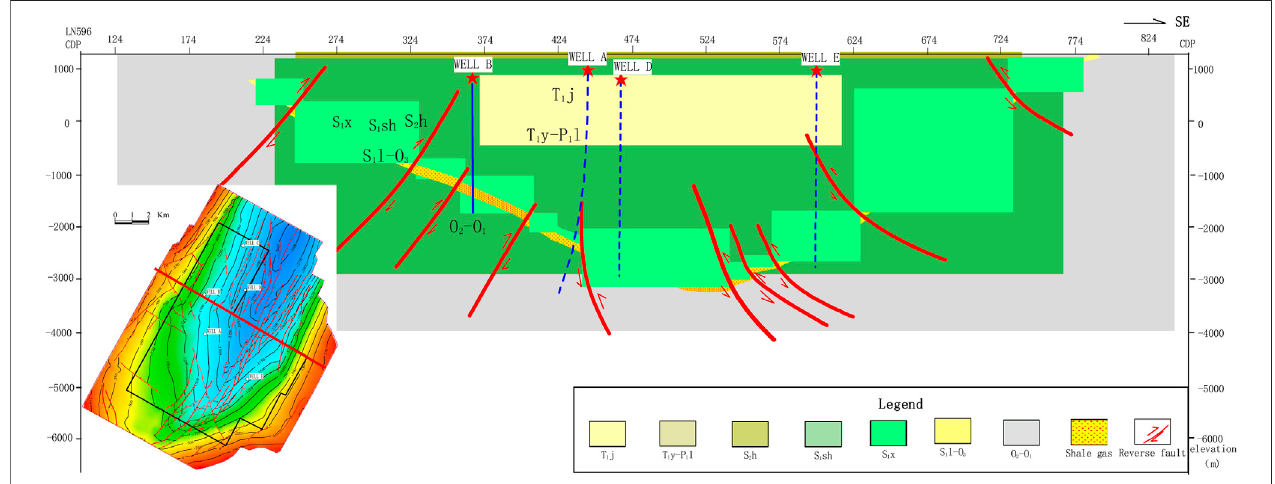
FIGURE 9 | The differential enrichment model of shale gas in upper Ordovician-Lower Silurian Wufeng-Longmaxi Formation in Anchang syncline.